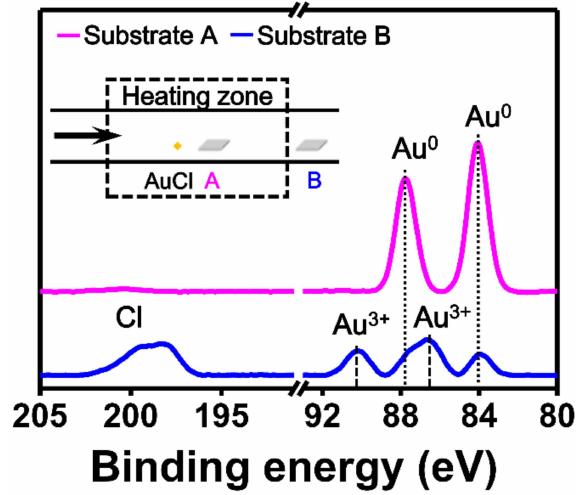
Figure 2. X-ray photoelectron spectroscopy (XPS) spectra obtained for two substrates placed in or out of the heating zone. Substrate A was positioned approximately 10 mm away from AuCl, and substrate B was positioned approximately 250 mm away from the precursor (inset). The binding energy peaks corresponding to Au 0 were measured on substrate A (magenta). Binding energy peaks corresponding to Au 3 + and Cl were measured on substrate B